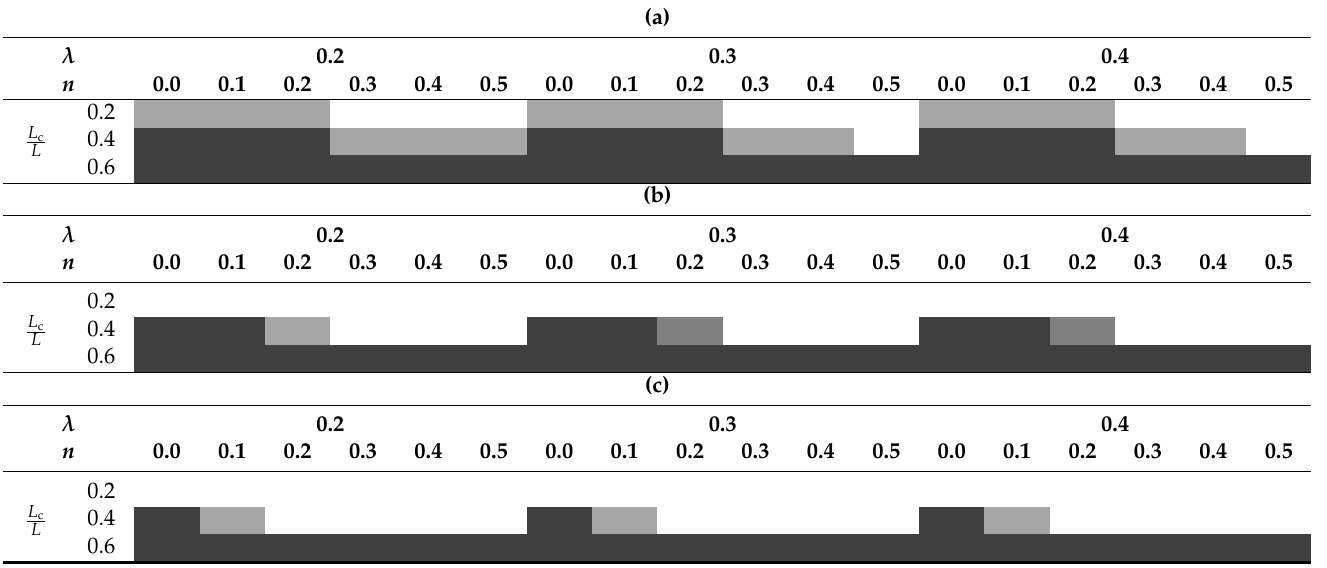
Table 2. Relationship between buckling position and design parameters: ( a ) Model with R = 0.06; ( b ) Model with R = 0.09; ( c ) Model with R =